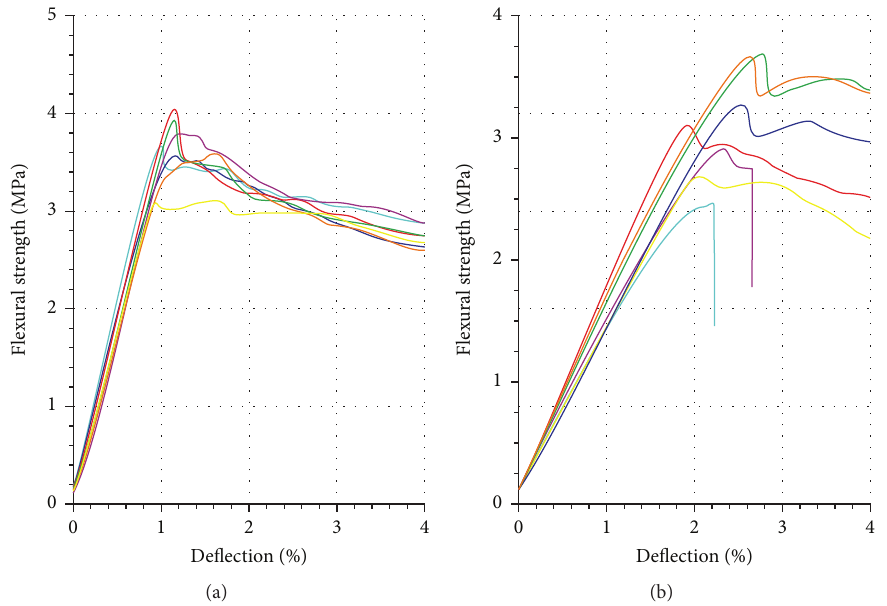
Figure 5: Examples of flexural characteristics of composite bending (a) T3 and (b) M2.